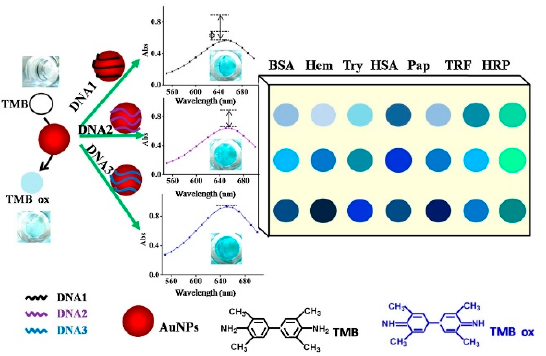
Figure 10. Schematic illustration of proteins discrimination by different AuNPs–DNA